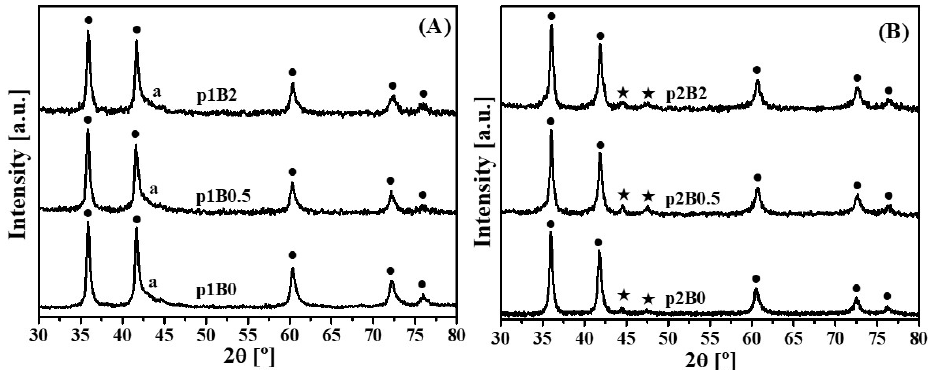
Figure 2. X-ray diffraction patterns of the powdered (Ti,Ta)(C,N)-Co-B based cermets. ( A ) First methodology ( p1B0 , p1B0.5 , and p1B2 ), ( B ) second methodology ( p2B0 , p2B0.5 , and p2B2 ), ( ) (Ti,Ta)(C,N) (Fm3m), ( a ) amorphized Co-Ti-Ta alloy, and ( ) Co (P63/mmc).